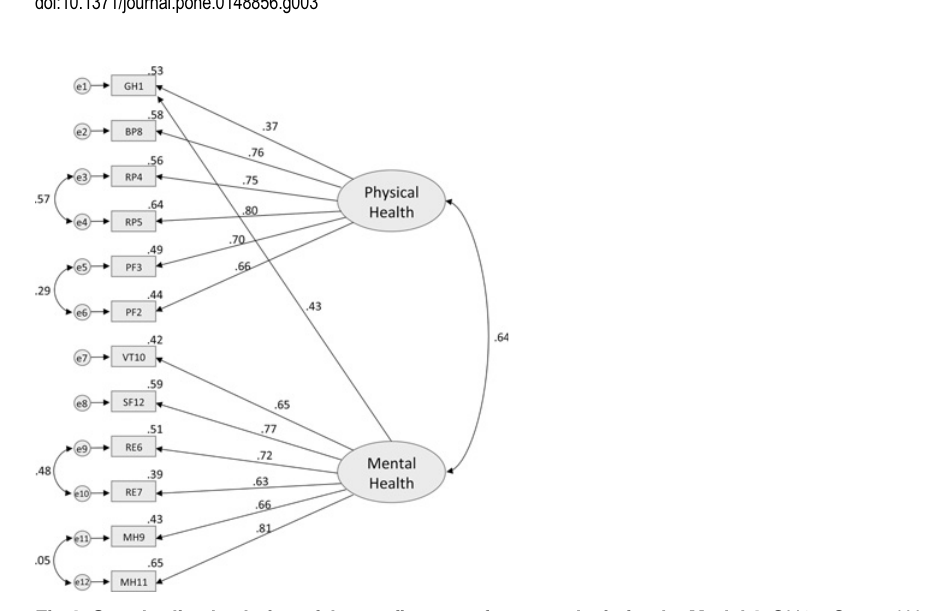
Fig 4. Standardized solution of the confirmatory factor analysis for the Model 4. GH1 — General Health: rating of general health; PF2 — Physical Functioning: moderate activities; PF3 — Physical Functioning: climbing several flights of stairs; RP4 — Role Functioning (Physical): accomplished less; RP5 — Role Functioning (Physical): limited in the kind work or other activities; RE6 — Role Functioning (Emotional): accomplished less (emotional problems); RE7 — Role Functioning (Emotional): less carefully than usual; BP8 — Bodily Pain: pain interference; MH9 — Mental Health: calm and peaceful; VT10 — Vitality: energy; MH11 — Mental Health: downhearted and depressed; SF12 — Social Functioning: health/emotional problems interfered with activities.